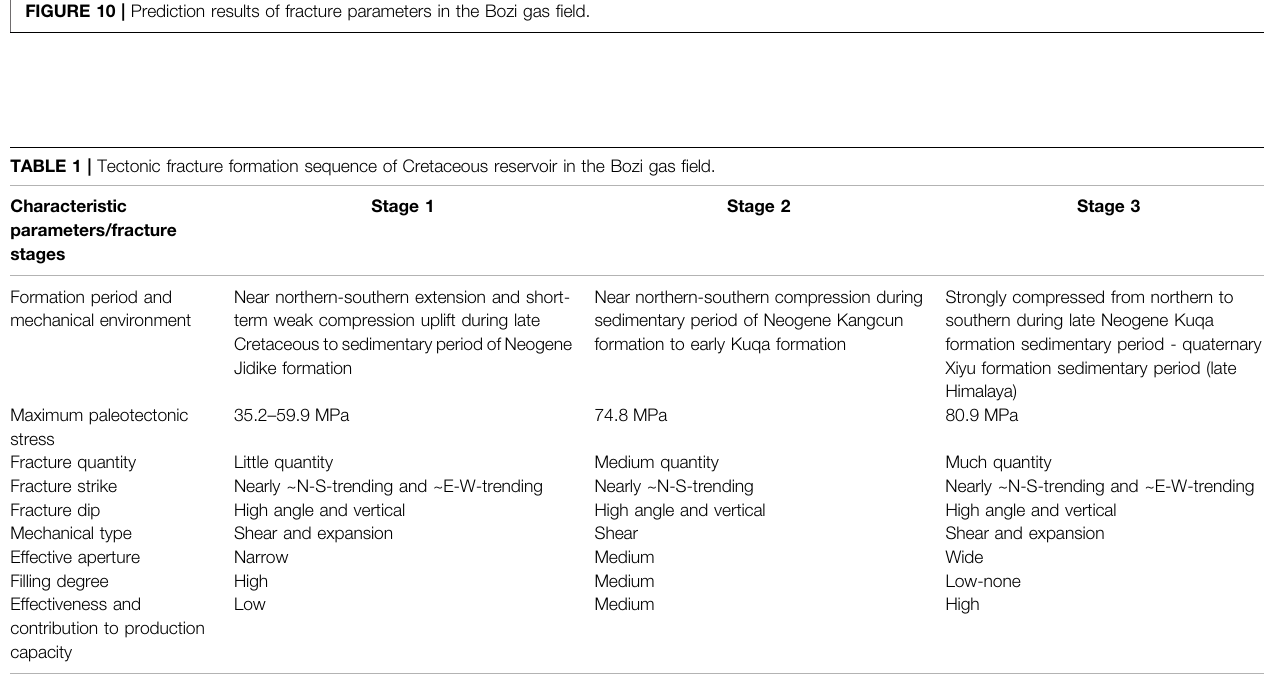
FIGURE 10 | Prediction results of fracture parameters in the Bozi gas fi eld.